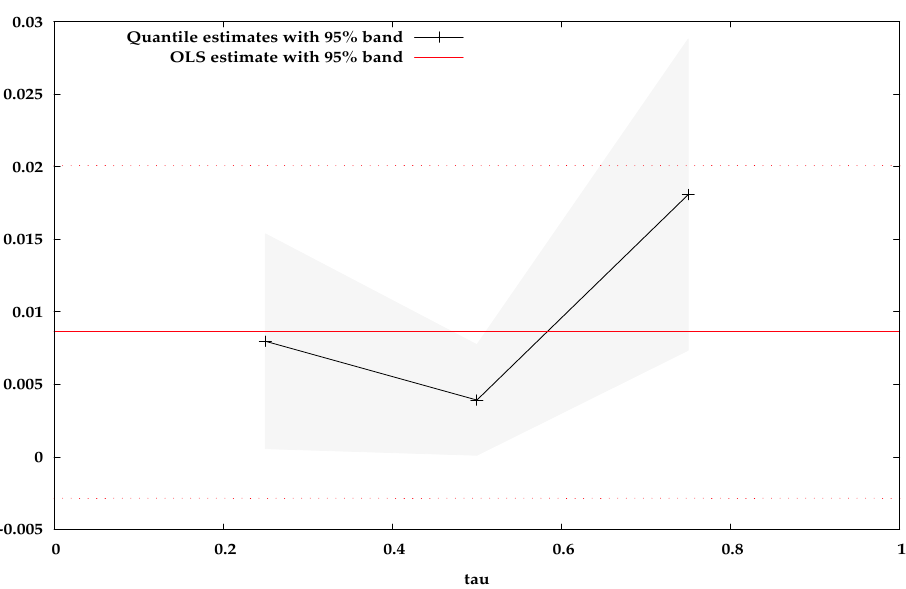
Figure 3. Quantile regression line for semi-deviation of returns vs. semi-deviation for ROA ( τ = 0.5).